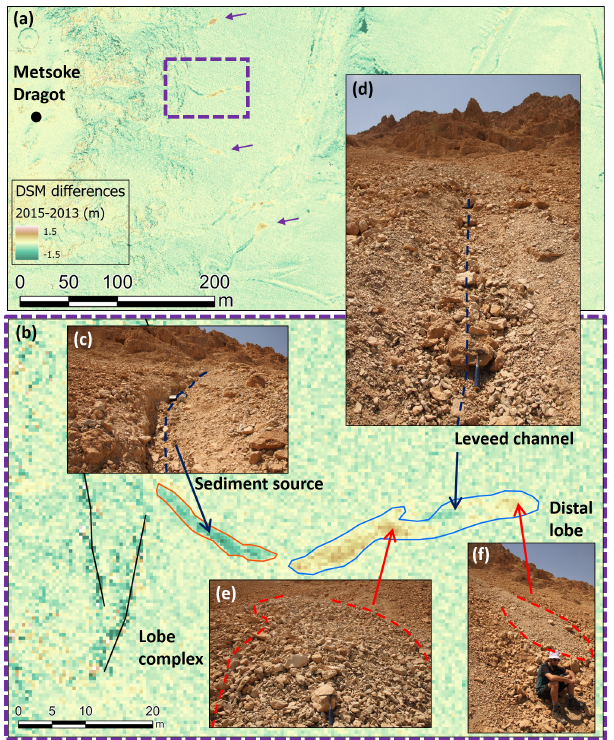
Figure 4. Mapping and characterization of debris flows in the field and the topographic models. (a) Natural changes on the steep slope east to Metsoke Dragot village as reflected from the DoD of the years 2013–2015. Brown shades suggest newly deposited materials while dark green shades represent new depressions. More details on the DF in the purple rectangle are shown in panels (b) to (f) . Arrows mark three additional DF deposits. (b) Zoom-in on the DF area, where the source of the debris material and the elongated de- posits are clearly seen on the map. Upper-slope cliffs (black lines) are noisier in the DoD. (c) A channel (dashed line shows its path) incised in the unconsolidated colluvium. (d) The DF channel with parallel levees on its margins. (e) Deposits of the lobe complex. (f) The distal